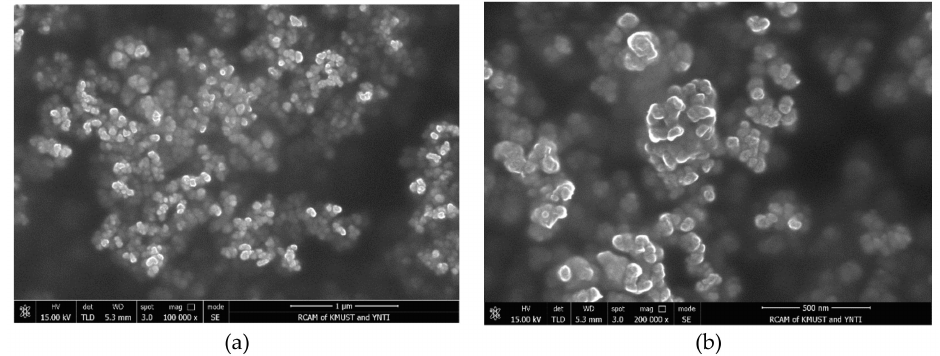
Figure 5. SEM photos of aniline tetramer under di ff erent magnification: ( a ) scale bar: 1000 nm; ( b ) scale bar: 500